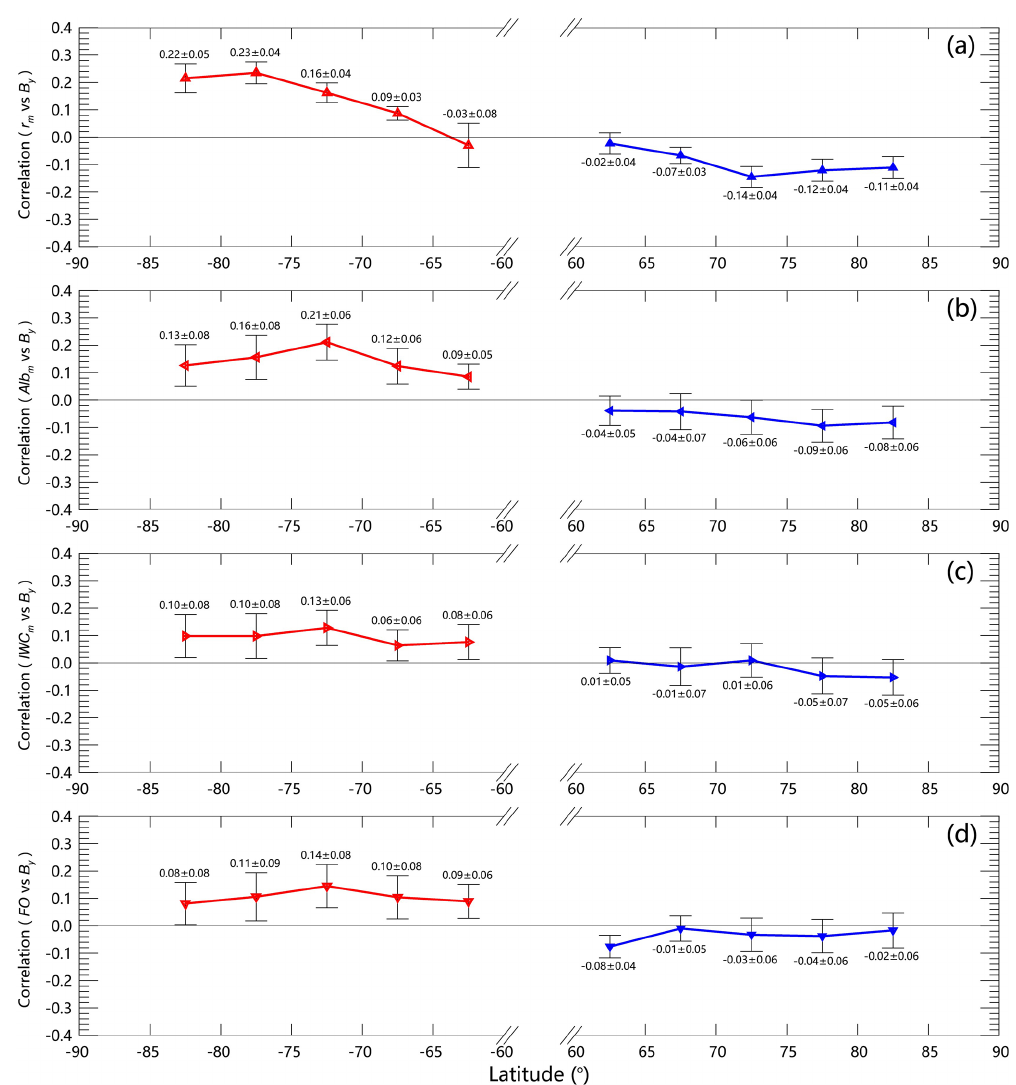
Figure 5. Correlation coefficients between the anomaly of r m , Alb m , IWC m and IMF B y at different latitude bands, with red and blue lines representing the mean correlation coefficients and error bars illustrating the standard deviation of the mean for the SH and NH,